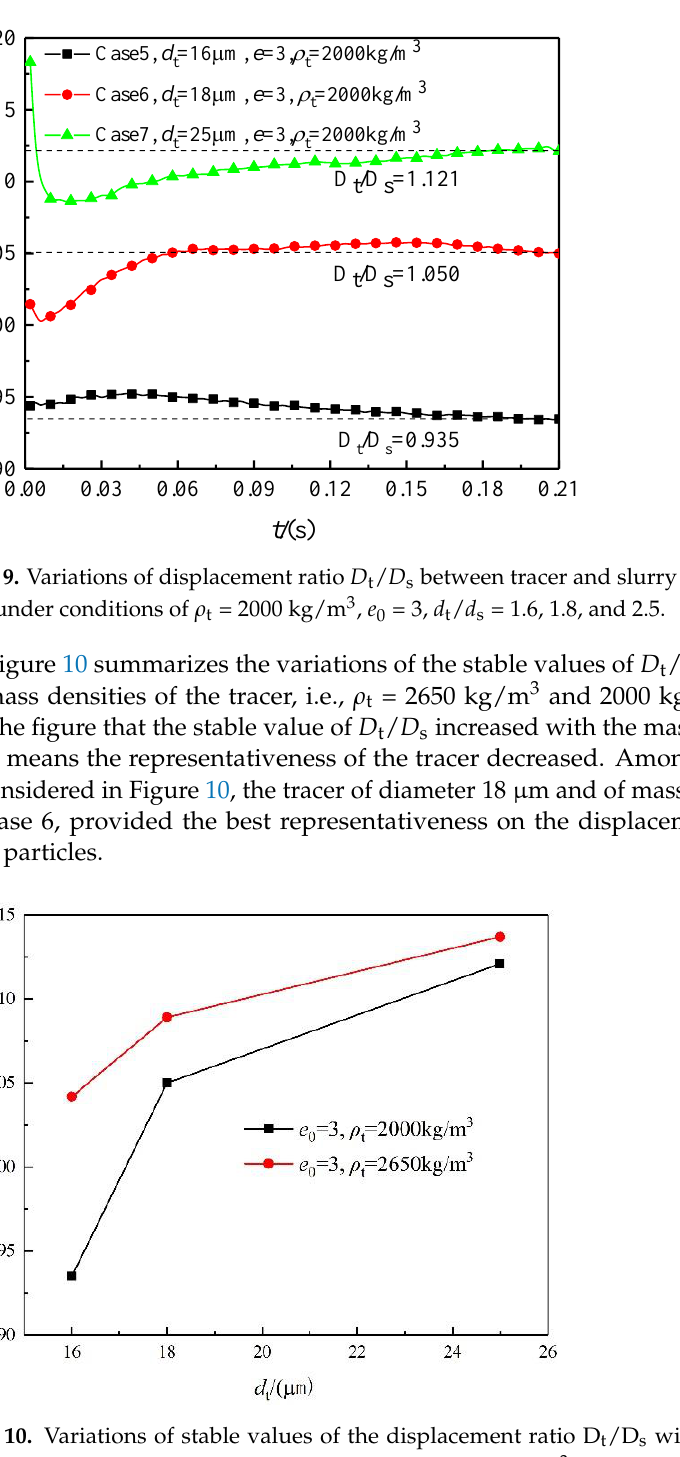
Figure 8. Variations of displacement ratio D t / D s between tracer and slurry particle with respect to time t under conditions of ρ t = 2650 kg/m 3 , e 0 = 3 and d t / d s = 1.6, 1.8 and 2.5. By reducing the mass density ρ t of the tracer from 2650 kg/m 3 to 2000 kg/m 3 and keeping e 0 = 3, Figure 9 compares the variation of D t / D s with t for the same diameter ratios d t /d s = 1.6, 1.8, and 2.5 (i.e., Cases 5~7 in Table 4). By comparing Figure 9 to Figure 8, it can be seen that the mass density of the tracer had little effect on the variation of D t / D s with time. However, the stable values of D t / D s were reduced, i.e., the reductions were about 1.4%, 3.5%, and 10%, respectively, for d t /d s = 1.6, 1.8, and 2.5.